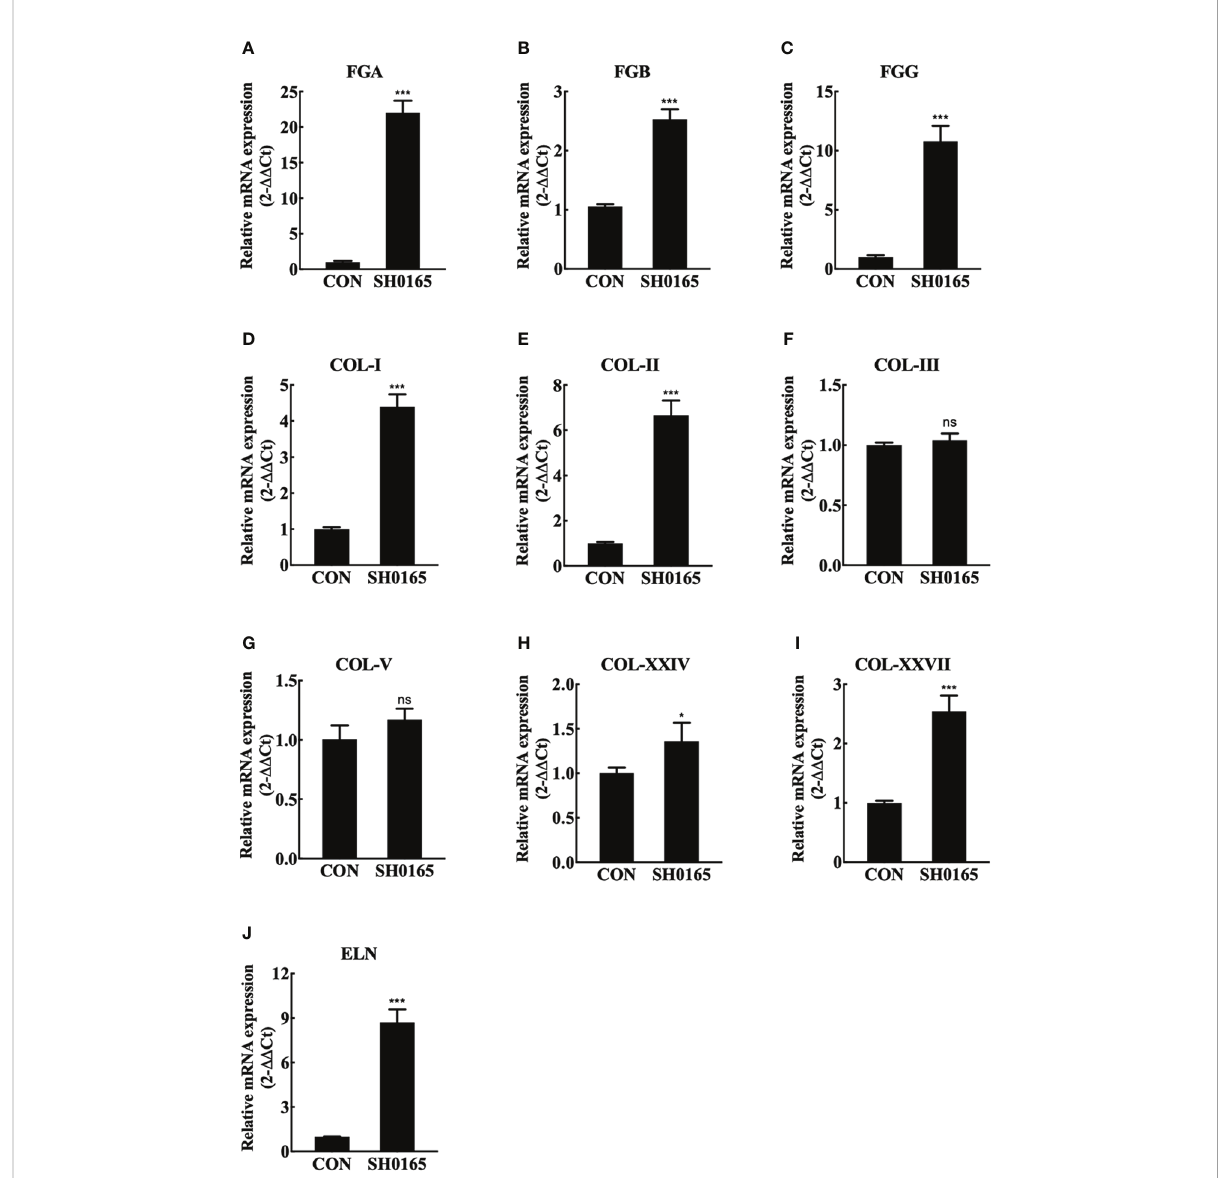
FIGURE 3 SH0165 infection up-regulated fi brin(ogen), fi bril-forming collagen and elastin in mRNA expression level. (A-C) fi brin(ogen) gene. (D-I) Fibril- forming collagen subfamily member. (J) ELN. Data were expressed as mean ± SD (ns: not signi fi cant, *p < 0.05, ***p <